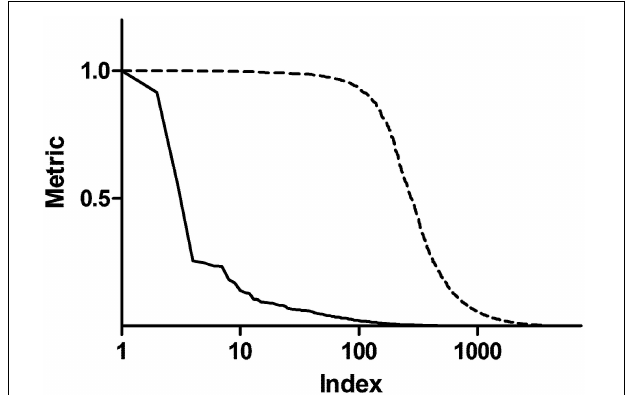
FIGURE 2 | Centrality metrics before and after Hill transformation. The solid line shows betweenness centrality obtained from the topological analysis of a representative personalized network. The dashed line represents centrality values after transformation with a Hill